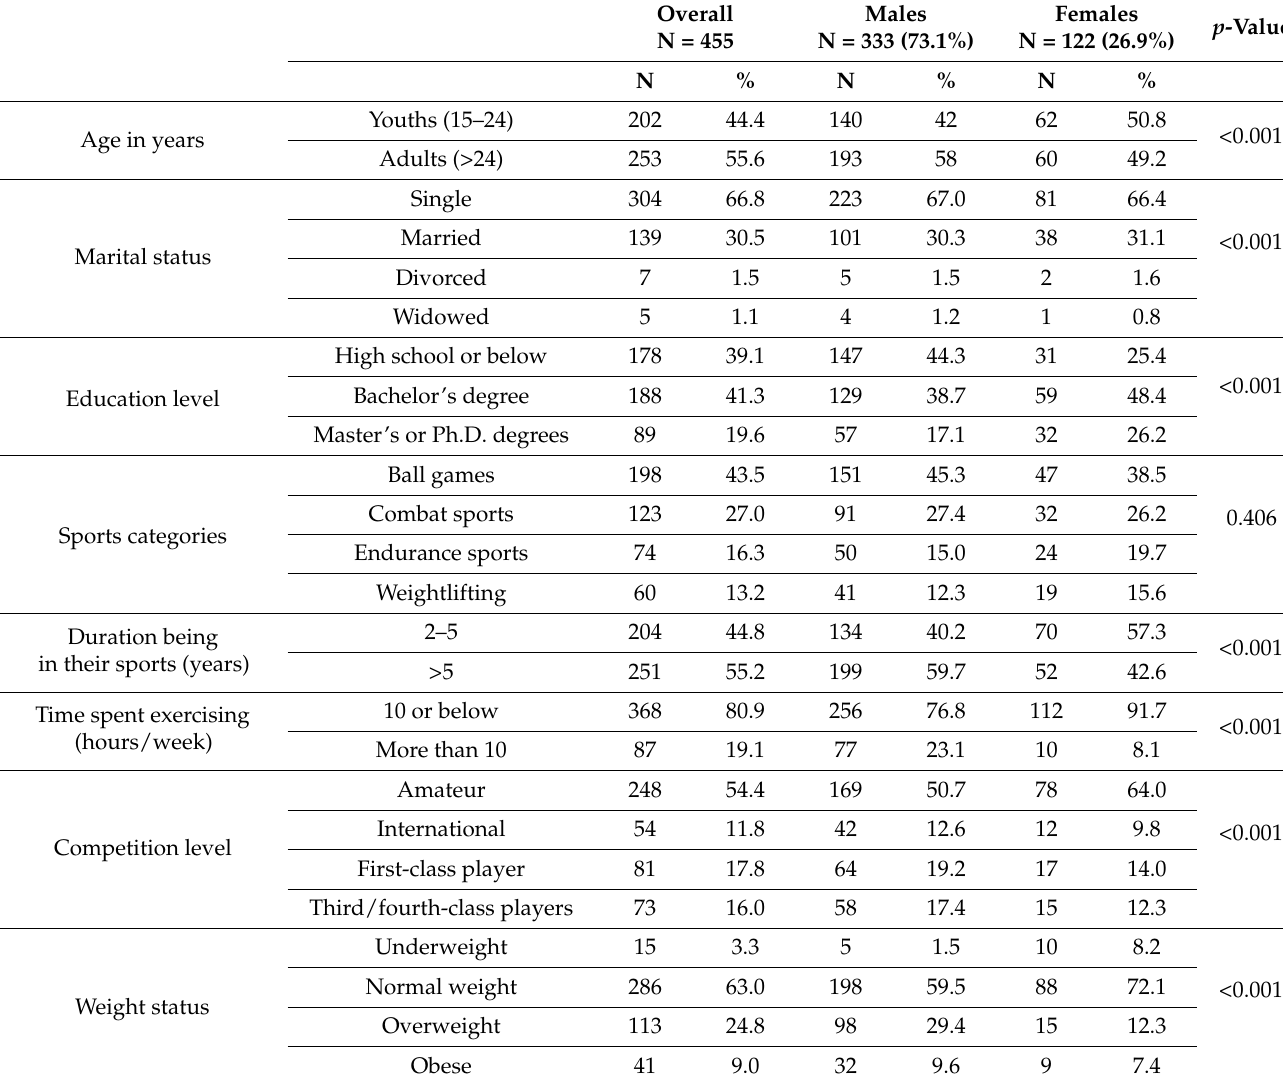
Table 1. Socio-demographic and personal information of